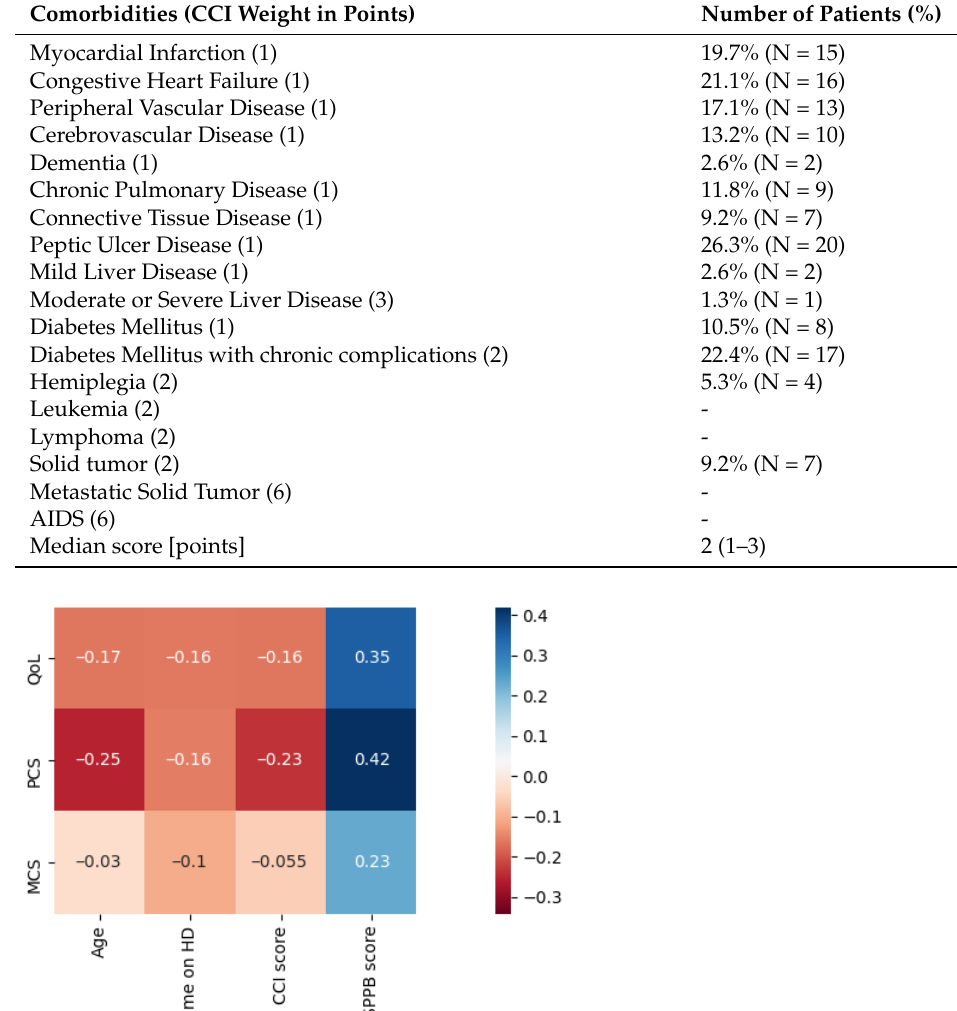
Table 3. Charlson Comorbidity Index scores.